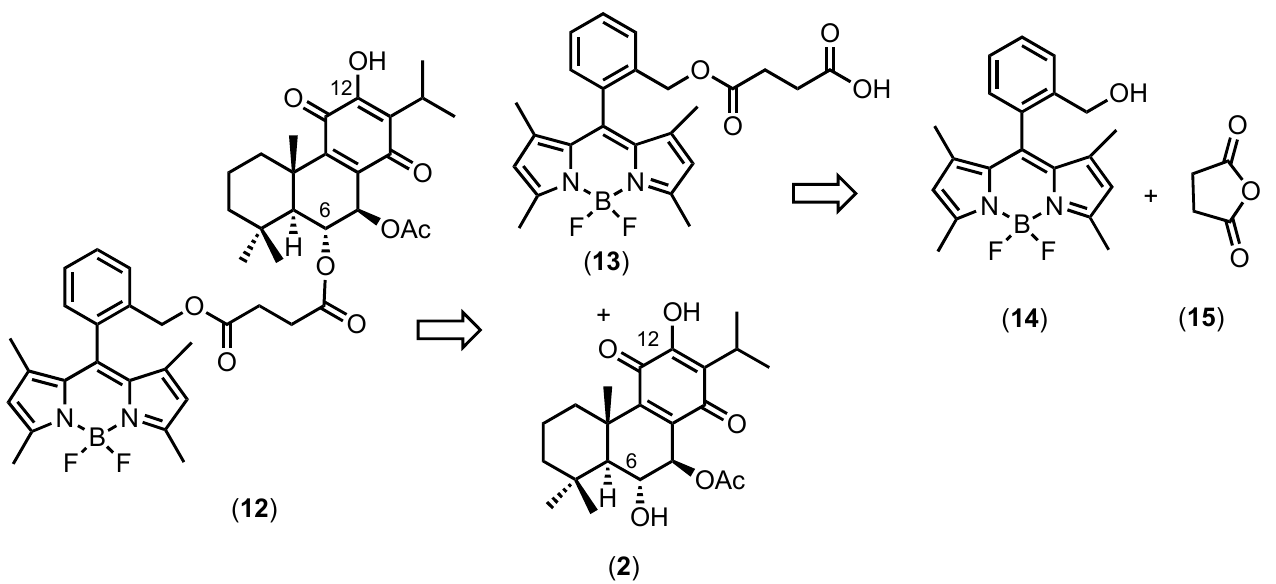
Figure 3. Retrosynthesis for the preparation of BODIPY-7 α -acetoxy-6 β hydroxyroyleanone derivative ( 12 ).